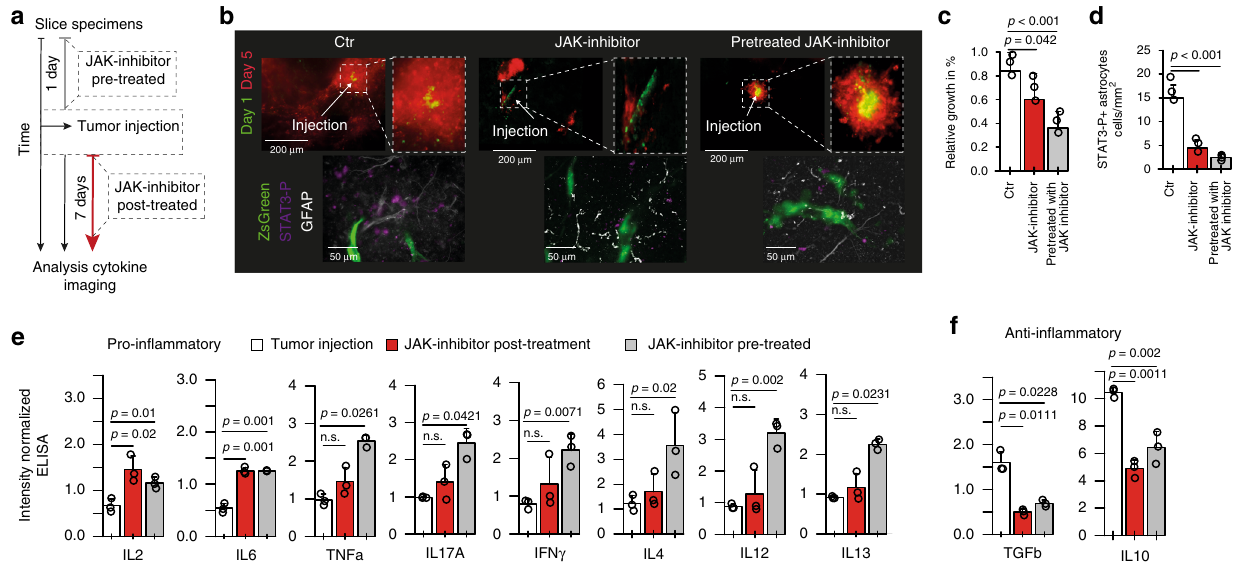
Fig. 6 Cytokine pro fi ling after JAK-inhibition. a Illustration of the work fl ow b Fluorescence imaging of the tumor growth in Ctr, JAK inhibition and pre- treated JAK-inhibitor slices condition. The time point of tumor injection is colored in green, the 5th day time point in red. On the bottom, immunostainings of the STAT3-P level in all experimental conditions. c Tumor growth in slices in all experimental conditions. d Number of STAT3-P cells per cm 2 . e Level of pro-in fl ammatory and anti-in fl ammatory cytokines in tumor injected slices administrated to either control conditions or JAK-Inhibitor (Ruxolitinib). f Level TGFb and IL10 in different treatment regimes. P -values were determined by one-way ANOVA adjusted by Benjamini – Hochberger for multiple testing. Data is given as mean ± standard deviation. Exact values of all cytokines are given in the source fi